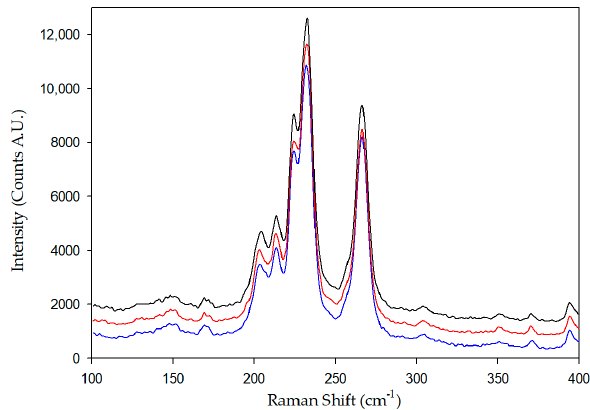
Figure 2. Radial Breathing Mode (RBM) from Figure 1a.